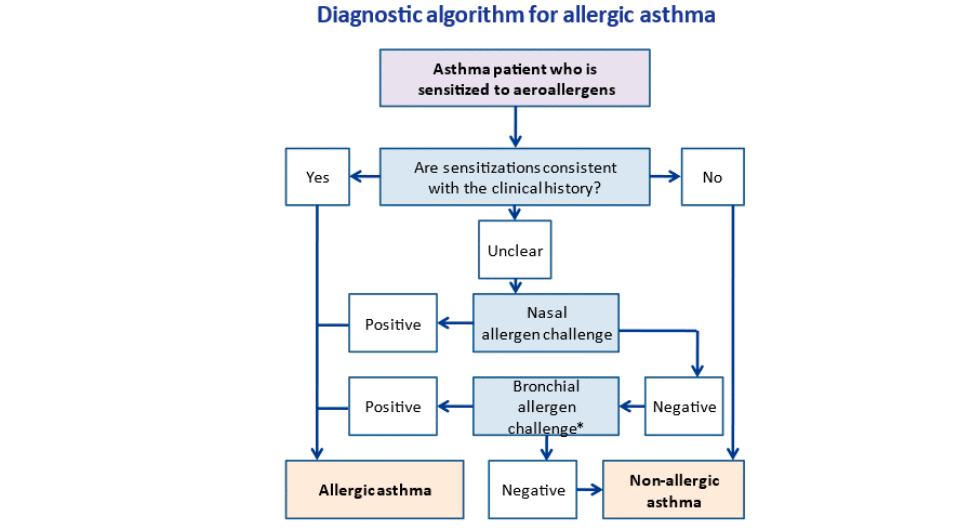
Figure 3. Diagnostic algorithm for allergic asthma.